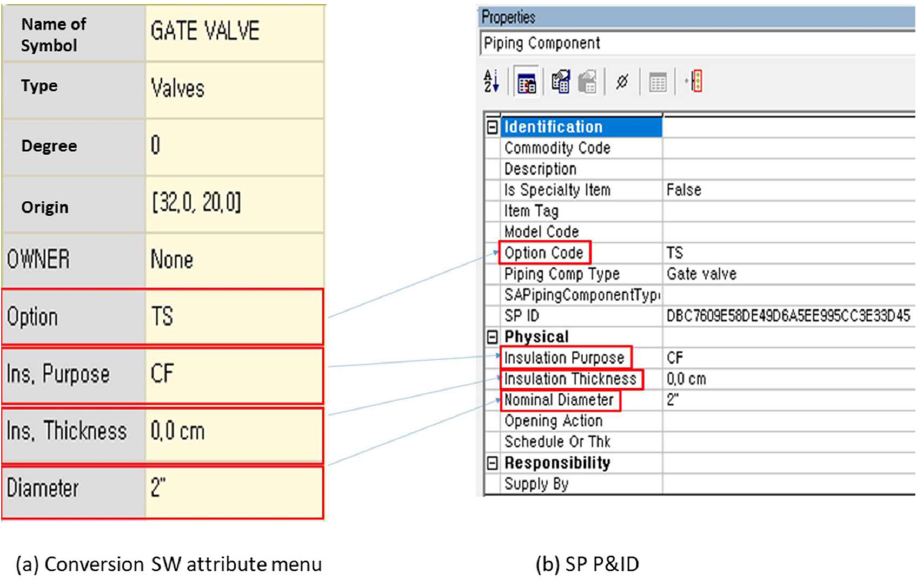
Figure 7. Mapping the attributes between the database and Smart Plant P&ID (SP P&ID) .